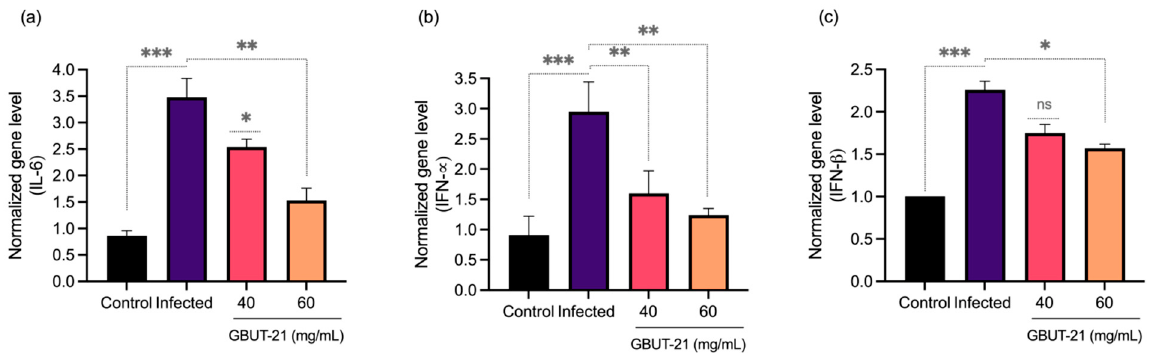
Figure 5. Gene expression of inflammatory markers in HEK 293 cells post infection with and without treatment of GBUT-21. ( a ) IL-6. ( b ) IFN- α . ( c ) IFN- β . An asterisk ( p < 0.05) indicates values that are significantly different from the control. Bars depict mean ± SD of three independent experiments. *** p < 0.001, ** p < 0.01, * p < 0.05 vs. virus (infected).